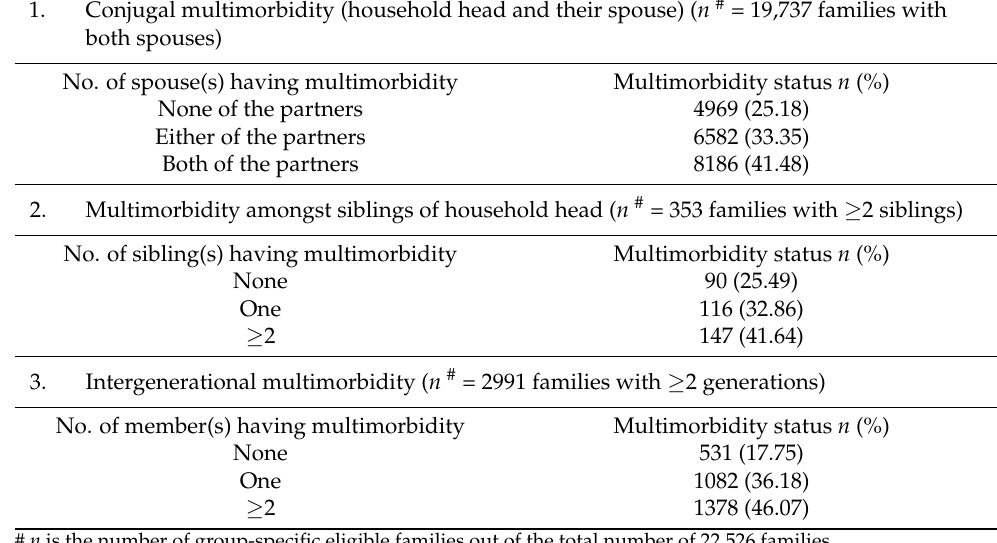
Table 3. Prevalence of multimorbidity amongst various groups of household members. 1. Conjugal multimorbidity (household head and their spouse) ( n # = 19,737 families with